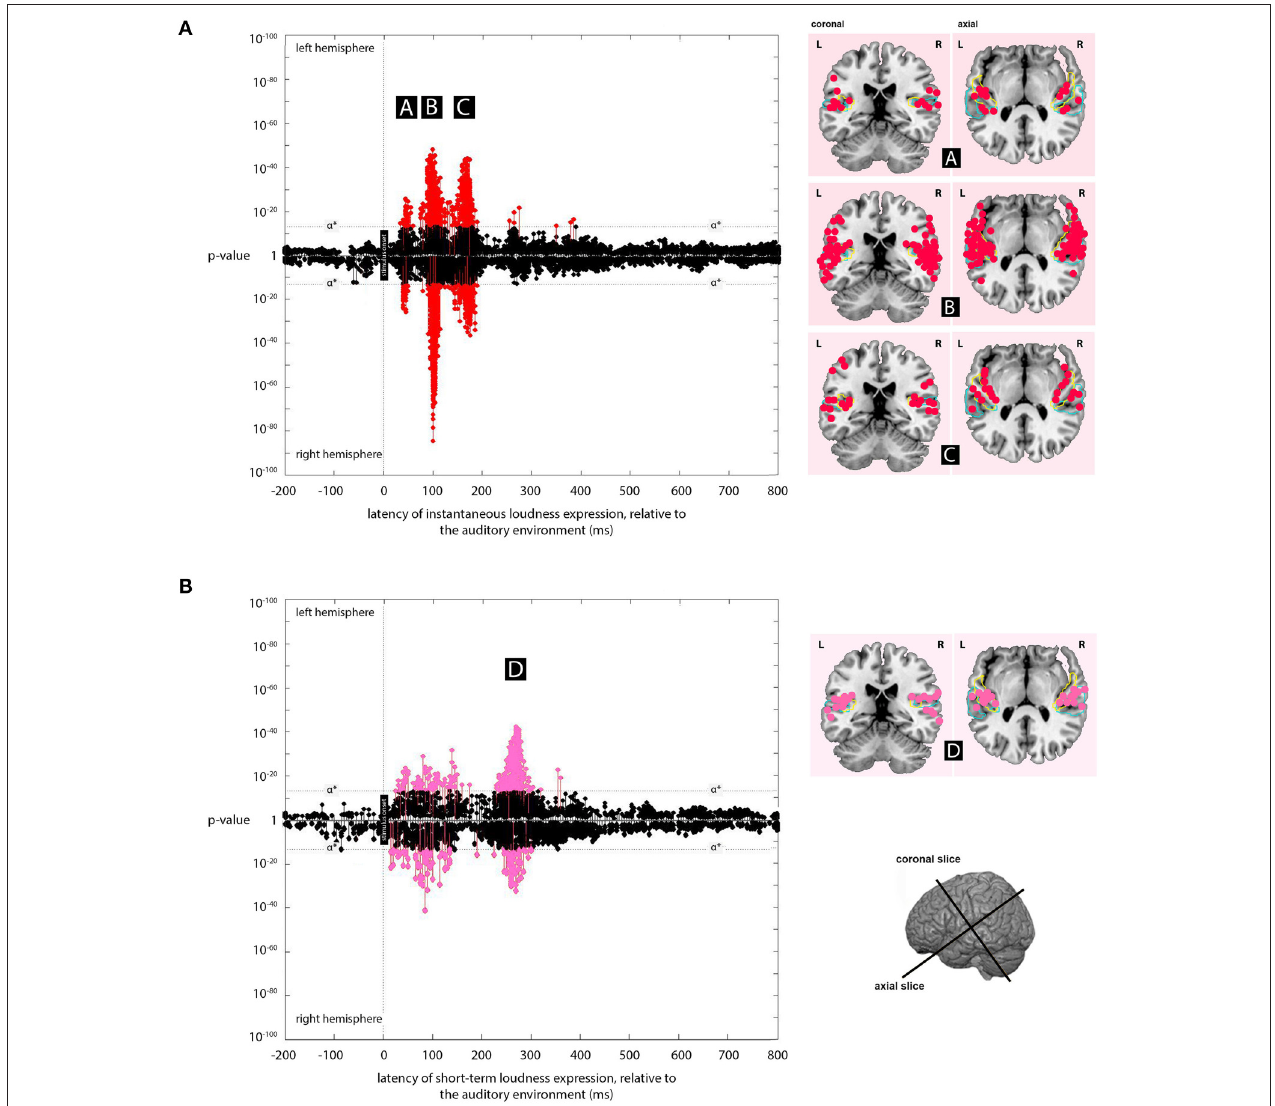
FIGURE 3 | Expression plots for the instantaneous loudness and short-term loudness models. (A) Plot of the expression for the instantaneous loudness model across processing lags from -200 to + 800ms, relative to the acoustic signal. Results for the left and right hemispheres are plotted separately, with the right hemisphere plots inverted to allow comparison between hemispheres. The minimum p -values at a given source, over all latencies, are marked as “stems.” Stems at or above the stipulated α * value ( p = 3 × 10 − 13 ) indicate significant expression of the instantaneous loudness model that are not explained better by the short-term loudness or Hilbert envelope models. These are marked in red. The cortical locations of significant sources at latencies, (A) (45ms), (B) (100ms), and (C) (165ms) (labeled in black boxes) are indicated on the coronal and axial slices to the right of the plot. (B) Plot of the expression for the short-term loudness model across processing lags from − 200 to +800ms, relative to the acoustic signal. Again, the cortical locations of significant sources at latency, (D) (275ms) (labeled in a black box) are indicated on the coronal and axial slices to the right of the plot. Both expression plots (with Figure 4 ) implement models selected so that each source appears only once in the three plots. Probabilistic anatomical landmarks in the slices are provided for planum temporale (light blue) and Heschl’s gyrus (yellow) (Rademacher et al., 1992; Morosan et al., 2001; Fischl et al.,